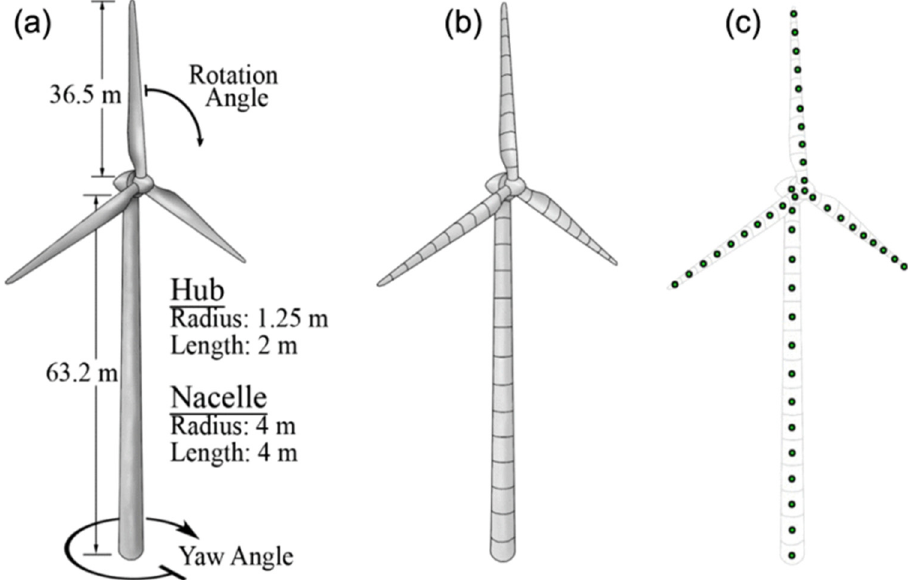
Figure 3. ( a ) CAD geometry of the basic 2MW turbine employed in the RSC modelling; ( b ) portioned turbine for RCS modelling; ( c ) the RCS point positioned at the center of each portion